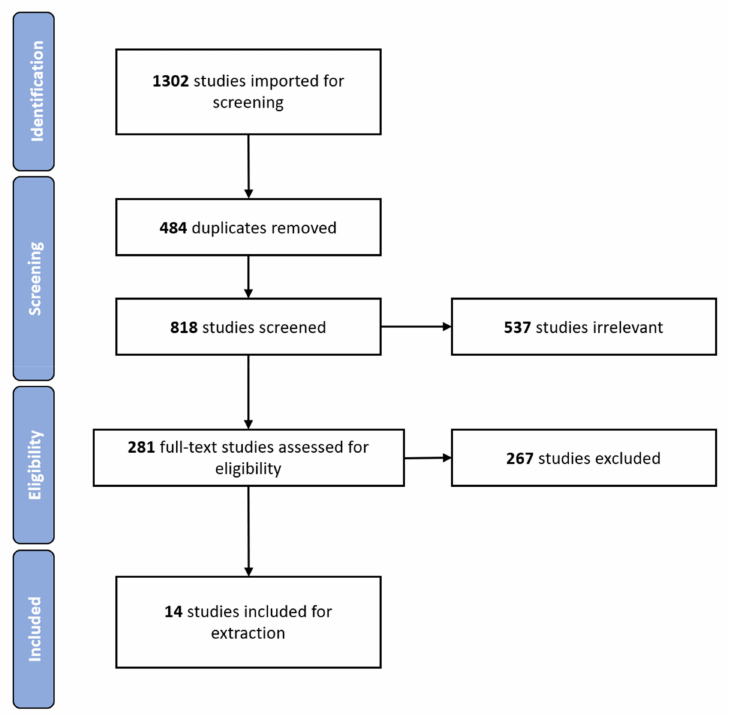
Figure 1. PRISMA flowchart indicating the publication screening and selection